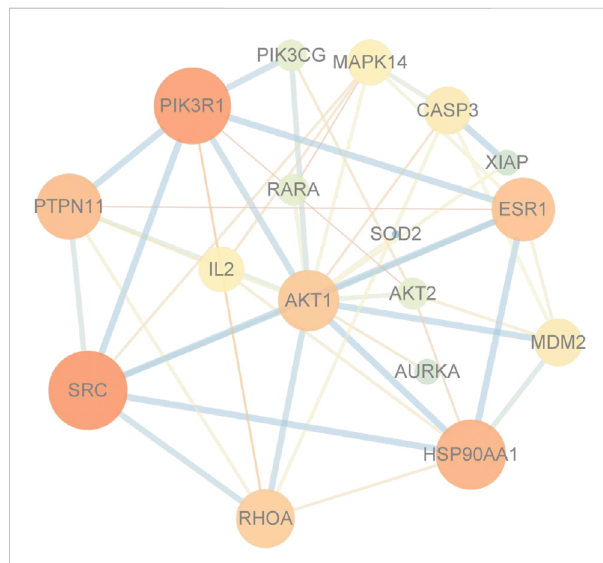
FIGURE 6 Protein-protein interaction network diagram. Core target